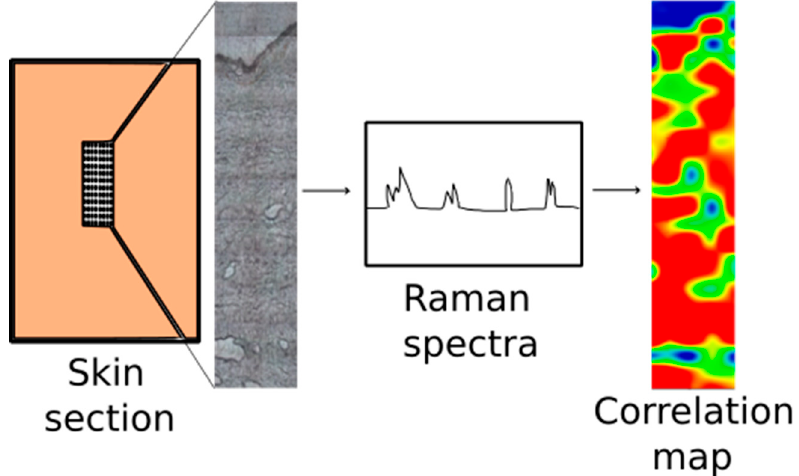
Figure 10. Raman chemical mapping.